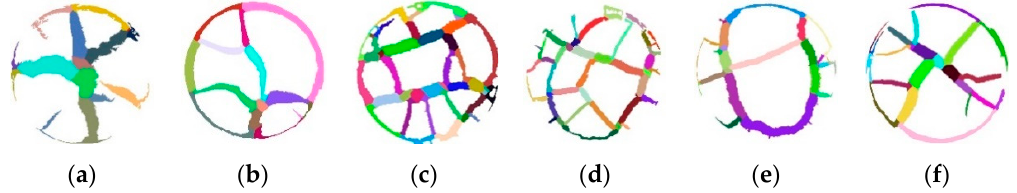
Figure 5. Segmented crack patterns of bentonite samples treated with various solutions at 48 hours: ( a ) sample W, ( b ) sample B, ( c ) sample C, ( d ) sample 25B75C, ( e ) sample 50B50C, and ( f ) sample 75B25C.